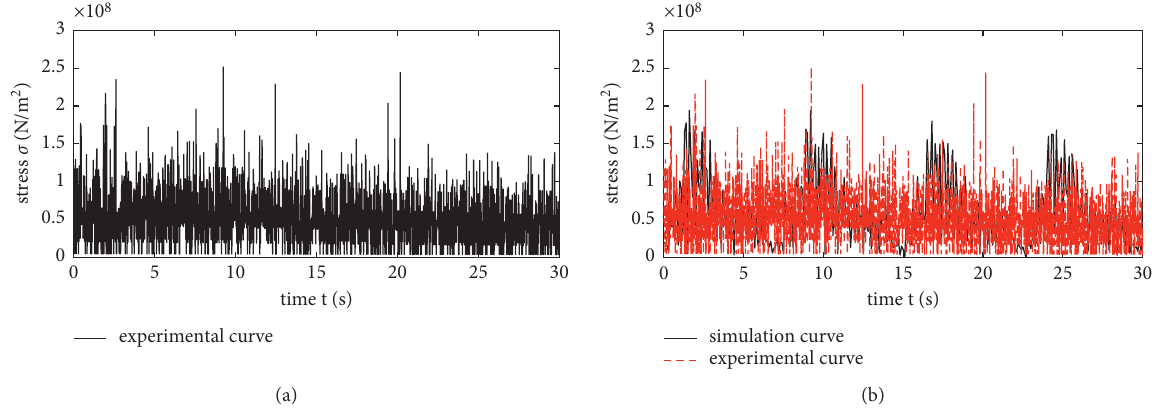
Figure 22: Comparison of stress results of supporting point. (a) Test result curve. (b) Comparison curves between the test model and calculation